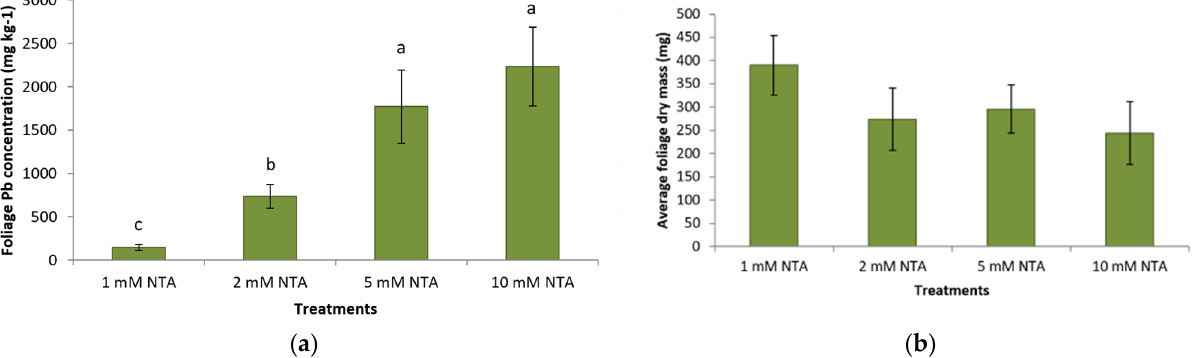
Figure 3. ( a ) Average ( ± SD) foliage Pb concentration (mg kg − 1 ) of Panicum virgatum at time of harvest. The means for columns designated with the same letter are not statistically significantly different ( α = 0.05). Treatments were different levels of NTA. ( b ) Average foliage DM (g) ( ± SD) of Panicum virgatum at time of harvest. The means for columns with same letter are not significantly different ( α = 0.05). Treatments were different levels of NTA.